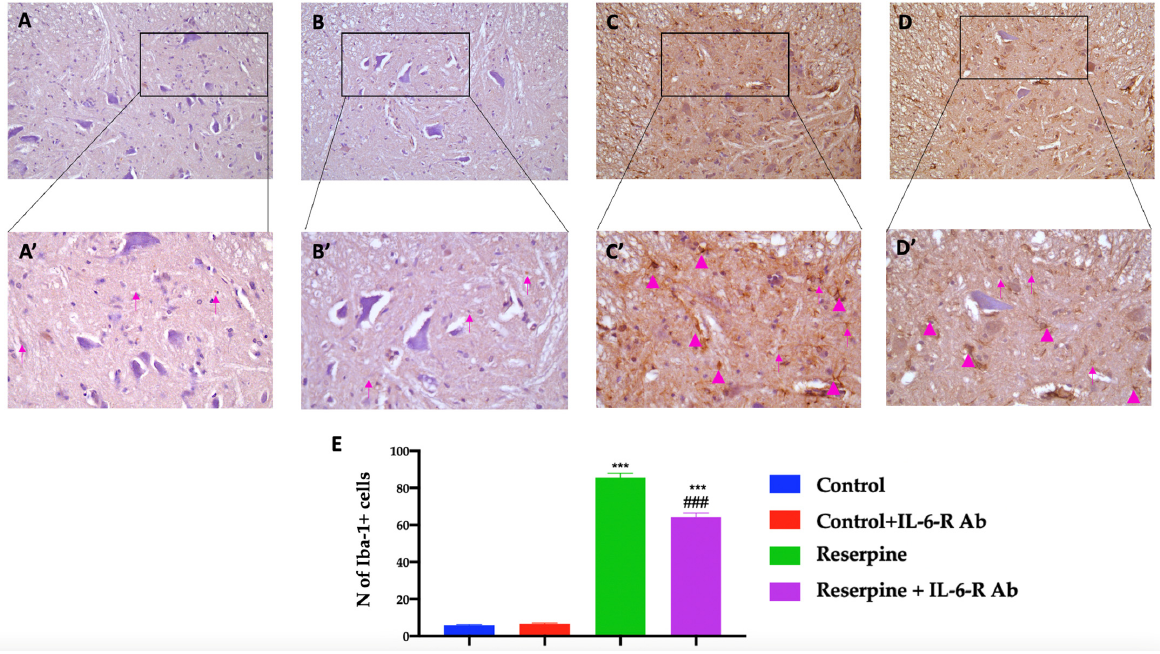
Figure 7. Effects of IL-6-R Ab on microglial activation: Immunohistochemical analysis of Iba-1 expressions: ( A , A’ ) control, ( B , B’ ) control + IL-6-R Ab, ( C , C’ ) reserpine, ( D , D’ ) reserpine + IL-6-R Ab, graphical quantification of Iba-1 expressions. Non-reactive glial cells are marked with an arrow, reactive glial cells are marked with an arrowhead, ( E ) N of Iba-1 +